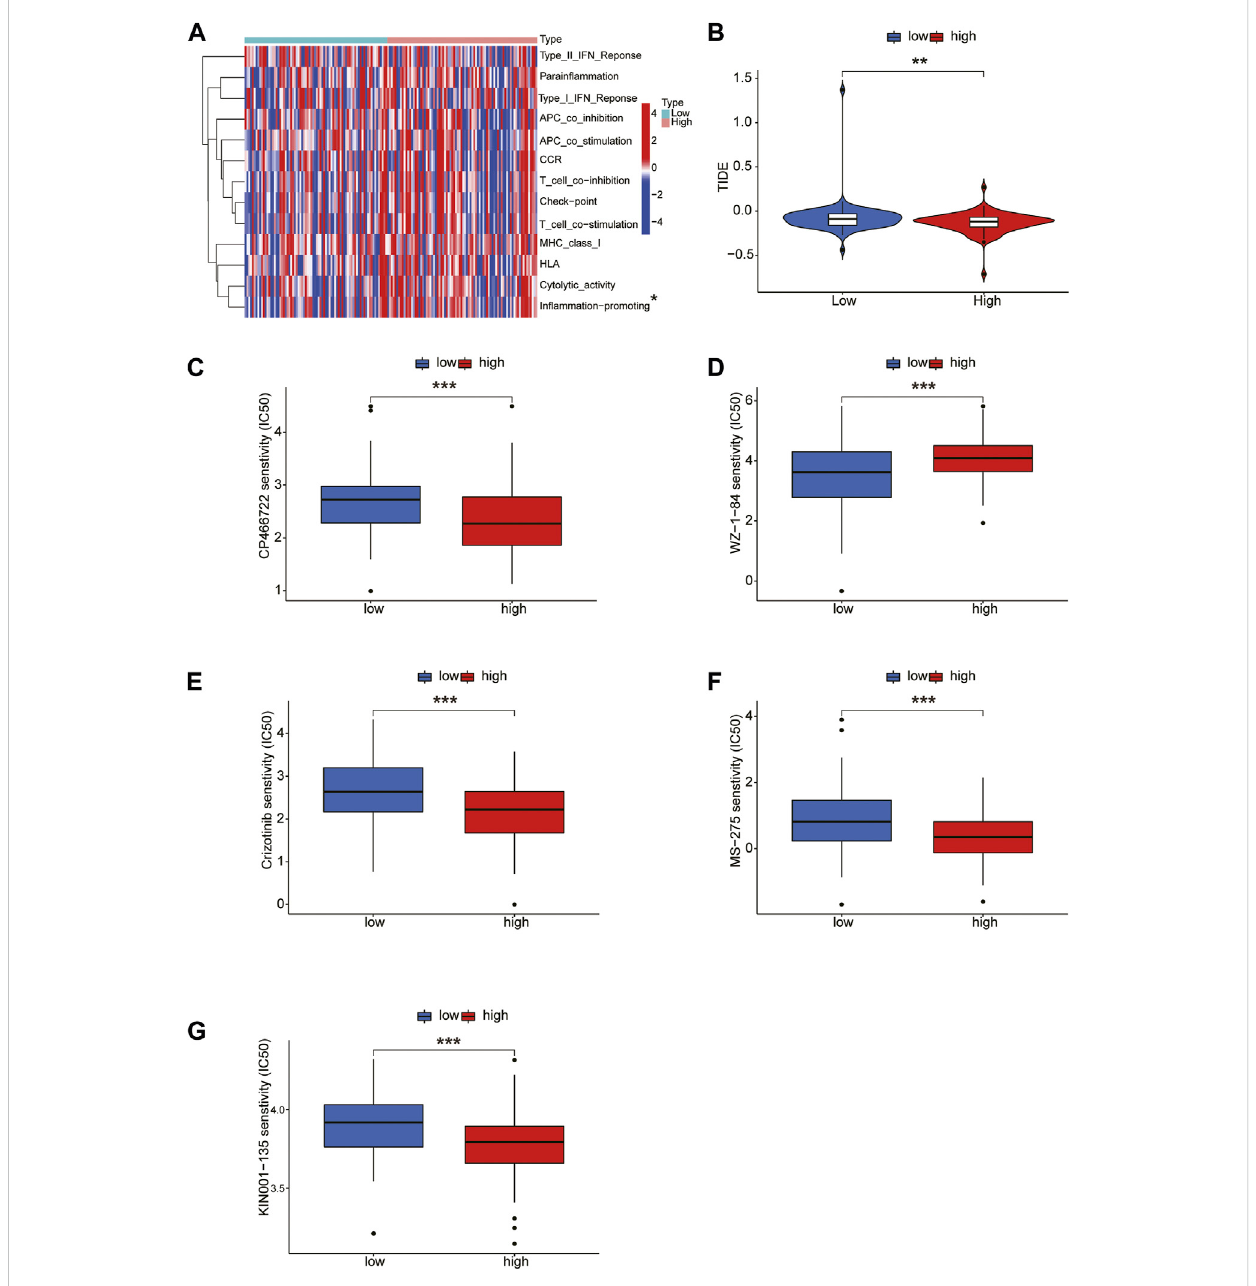
FIGURE 8 Immune-related function analysis and drug sensitivity. (A) Immune-related function analysis of CRLs. (B) Tumor immune dysfunction and exclusion (TIDE) algorithm analysis for high-risk and low-risk groups. Drug sensitivity of CP-466722, crizotinib, MS-275, KIN001-135, CP-466722 (C – G) .